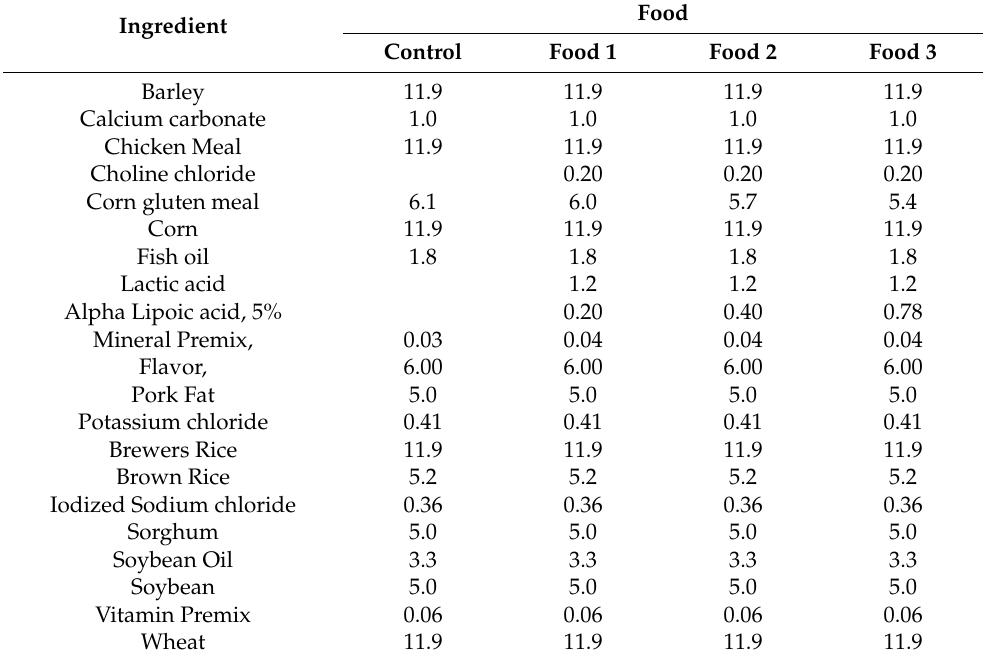
Values shown as percentage of total